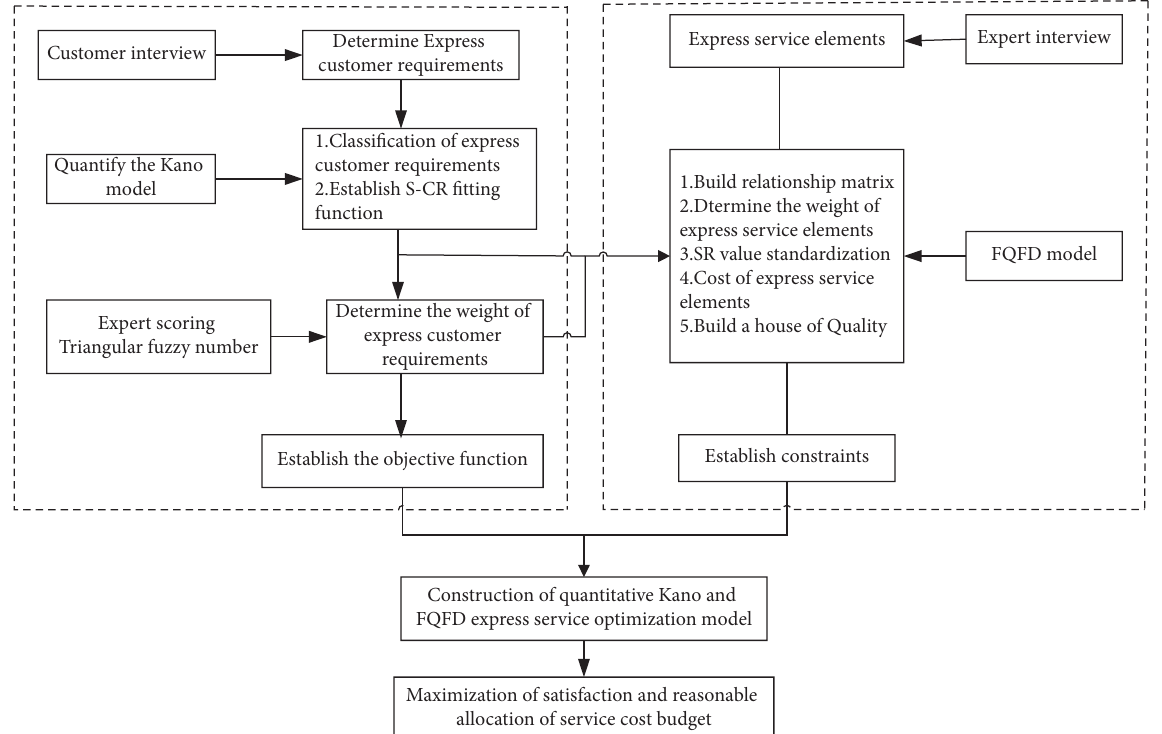
Figure 2: The framework of optimization design of express service based on QKANO and